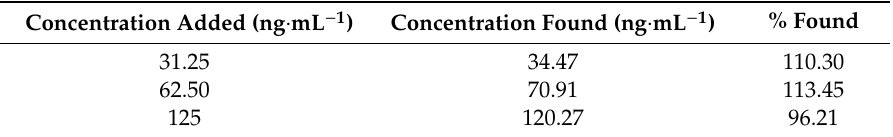
Table 1. Results for ferritin spiked into human serum